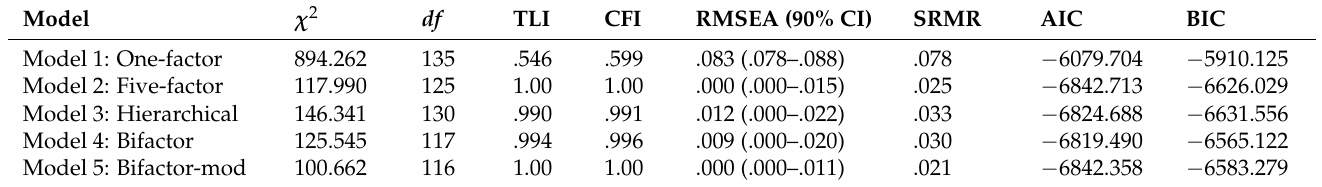
Table 3. Fit of the Four Factor Models to the GECo Branches and Raven’s Advanced Progressive Matrices-Short Form.